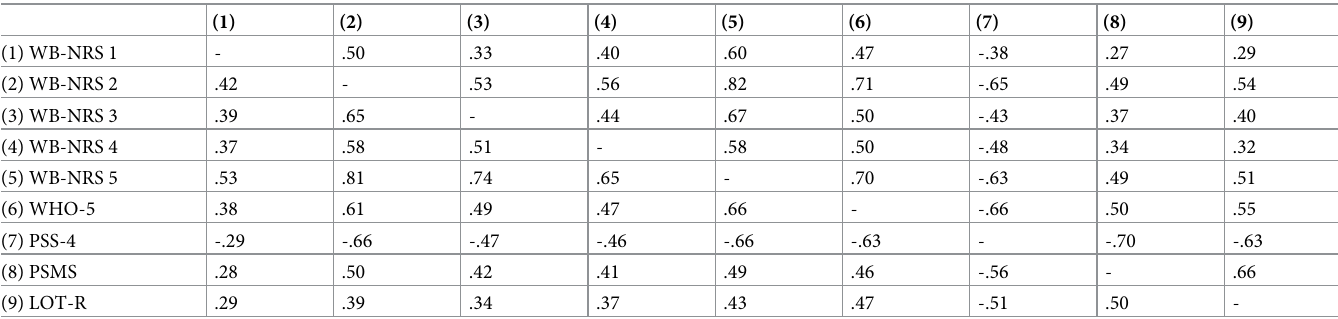
Table 8. Bivariate Bayesian correlates between the Well-being Numerical Rating Scales (WB-NRSs) and the other variables in the